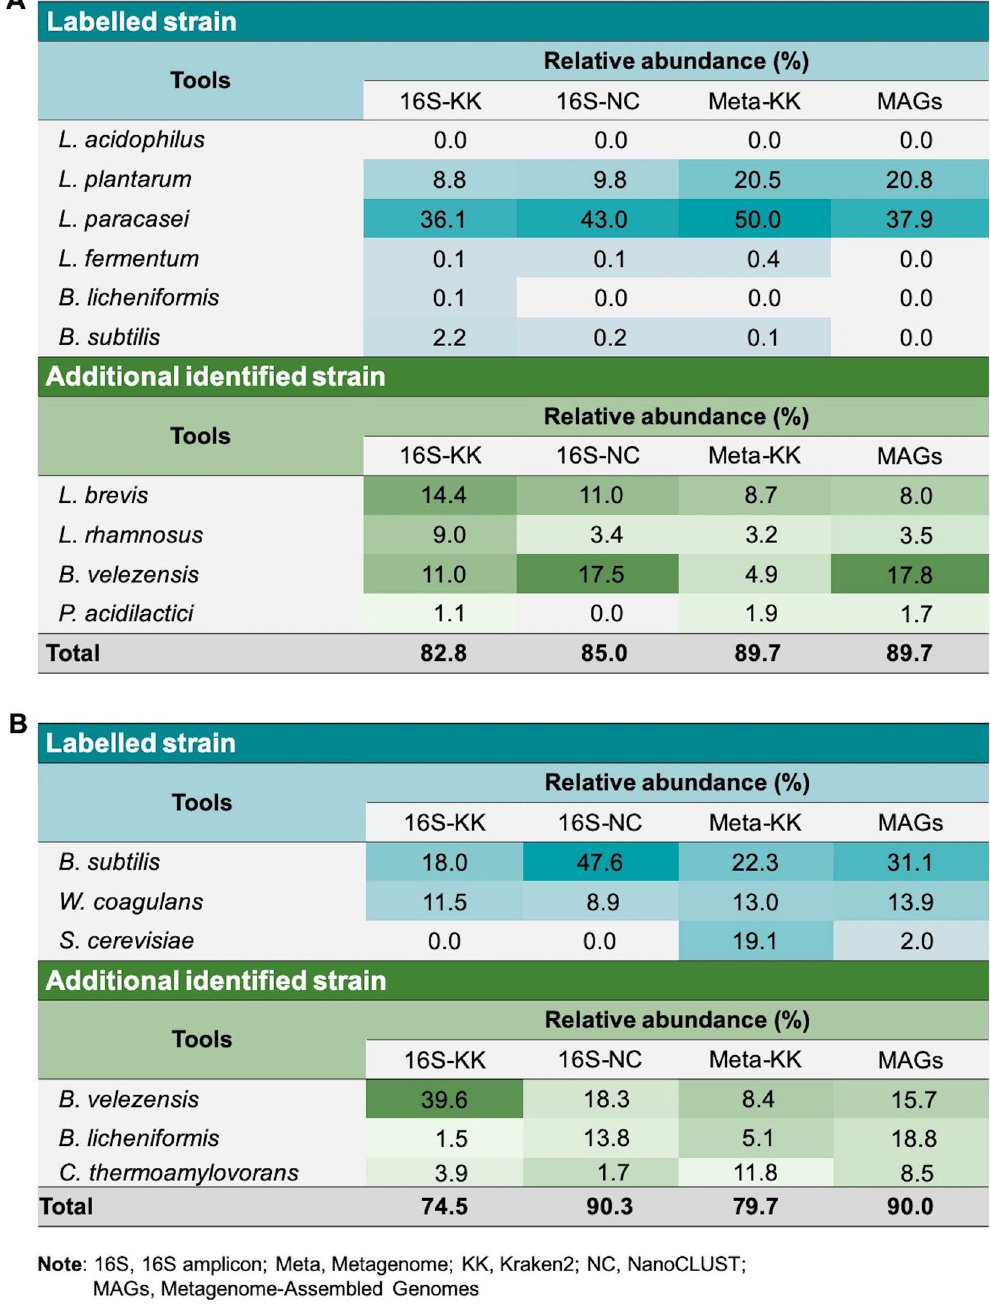
Figure 2. Percentage of relative abundance of labelled and additional identified strains of animal probiotic Product A ( A ) and Product B ( B ). Strains are retrieved from either 16S amplicon data against Kraken2 (16S-KK) and NanoCLUST (16S-NC) or metagenomic data against Kraken2 (Meta-KK) and metagenomic-assembled genomes (MAGs). The additional identified strains exhibit representative strains from at least three techniques. The total relative abundance values are indicated as a total of classified bacteria in both labelled and additional identified strains by each classification approach. Missing data indicate strains that could not be identified from metagenomic sequenced